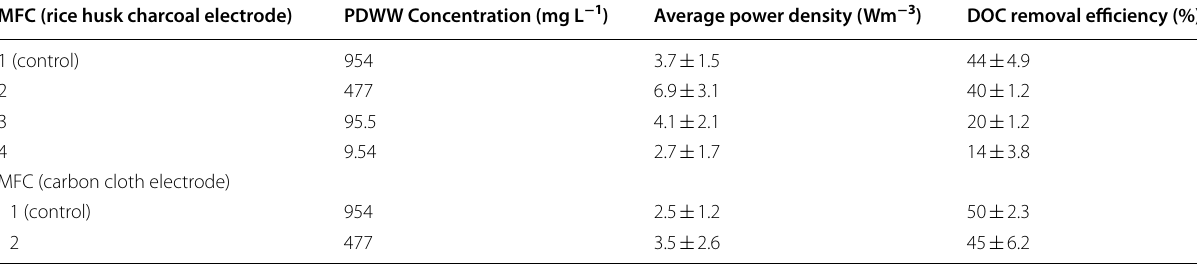
Table 2 Performance of poultry droppings-fed MFC at different substrate concentrations under continuous operation MFC (rice husk charcoal